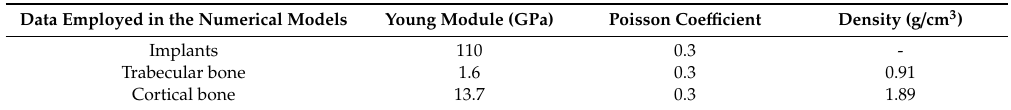
Table 2. Initial data employed in the numerical models for the M-12 and Astra implants considering bone type (III). The structure and arrangement of the di ff erent tissues can be seen in Figure 1. Data Employed in the Numerical